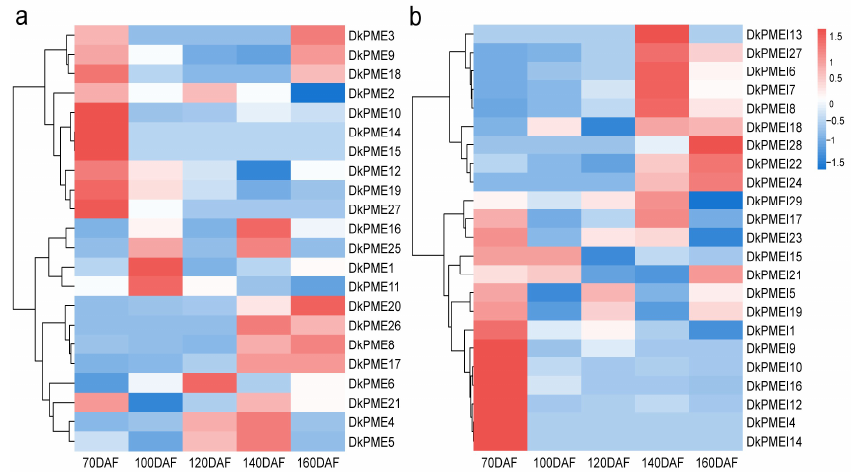
Figure 8. Gene expression of ( a ) DkPME and ( b ) DkPMEI genes during fruit development.